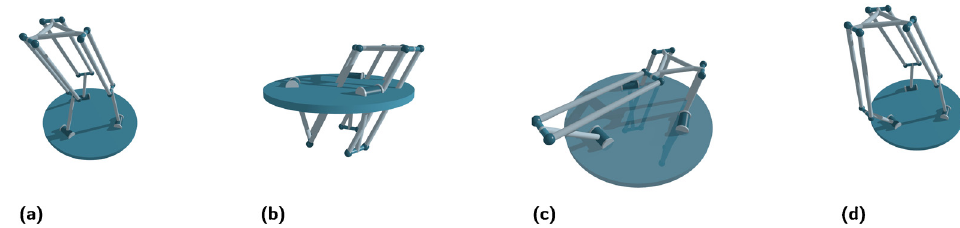
Figure 9: Singular poses of the delta robot, 6, . ( a ) First orbit, ( b ) second orbit, ( c ) third orbit, ( d )